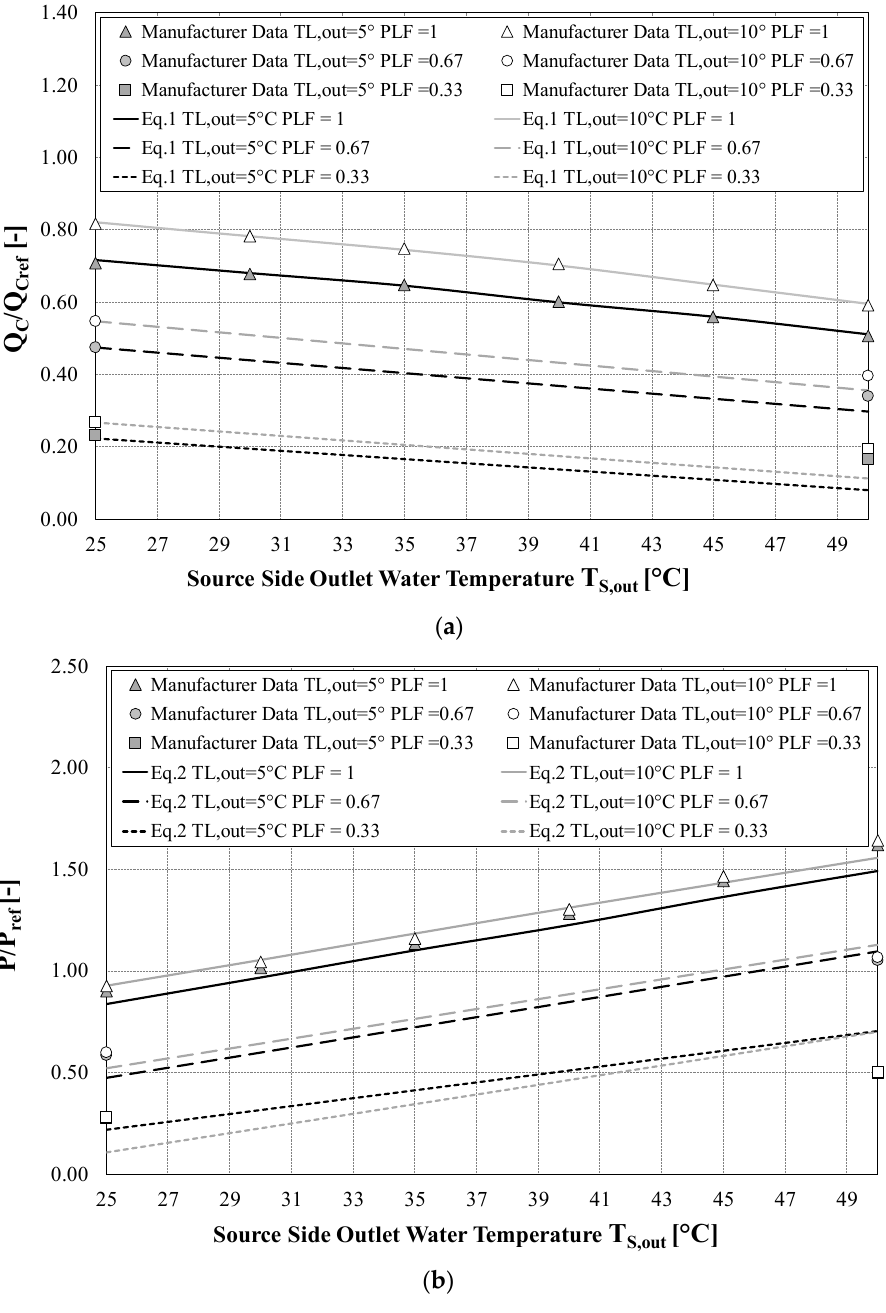
Figure 2. ( a ) Q C / Q C ref and ( b ) P / P ref comparison for cooling mode.